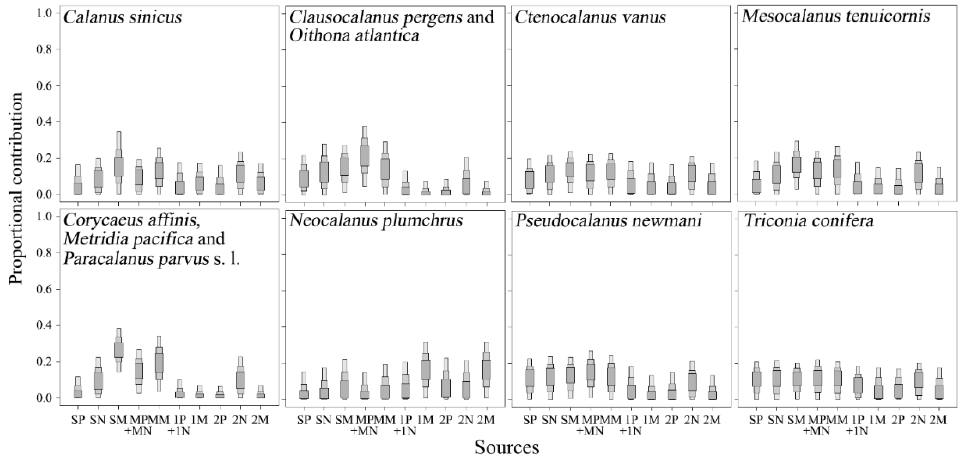
Figure 6. The stable isotope analysis in R mixing model results show contributions of pico-, nano-, and micro-particulate organic matter (POM) at the surface (0 m, 10 m), SCM, 100 m, and 200 m depth layers to the diets of copepods in the south region of the subpolar front using δ 13 C and δ 15 N values. The shaded boxes (dark to light) show 50%, 75%, and 95% credibility intervals for mean estimates. SP, surface layer pico-POM; SN, surface layer nano-POM; SM, surface layer micro-POM; MP, SCM layer pico-POM; MN, SCM layer nano-POM; MM, SCM micro-POM; 1P, 100 m depth layer pico-POM; 1N, 100 m depth layer nano-POM; 1M, 100 m depth layer micro-POM; 2P, 200 m depth layer pico-POM; 2N, 200 m depth layer nano-POM; 2M, 200 m depth layer micro-POM.